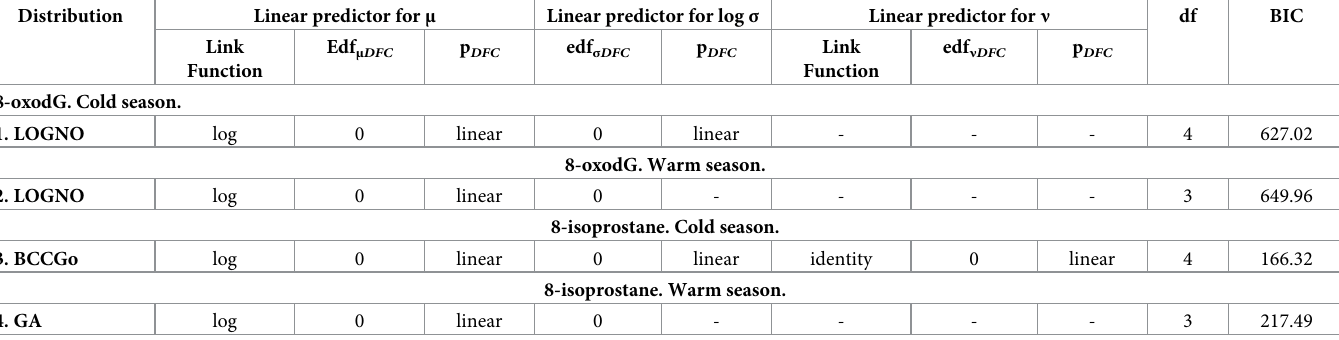
Table 2. The best GAMLSS models for the 8-oxodG and 8-isoprostane during the cold and warm seasons with linear predictors for median μ , variability σ and skew- ness ν .